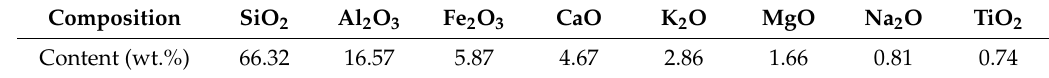
Table 1. Soil composition in this